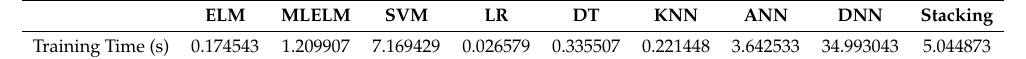
Table 4. The average training time in seconds (s) for each method. ELM MLELM SVM LR DT KNN ANN DNN